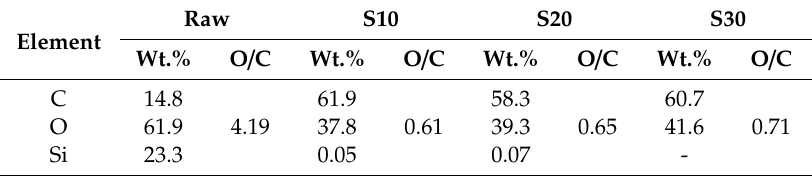
Figure 6. Scanning electron microscope (SEM) images of raw ( a ) and alkaline scoured S10 ( b ), S20 ( c ) and S40 ( d ) rice husk.